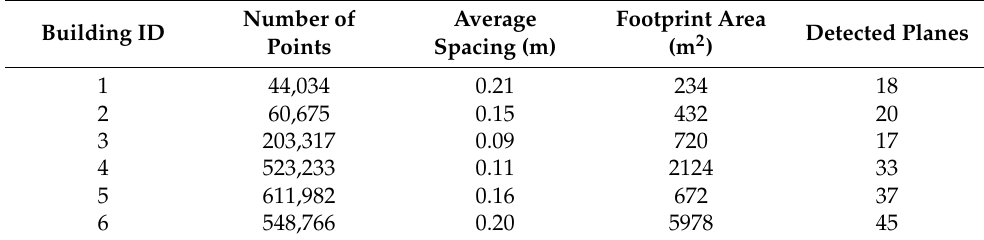
Table 1. Basic information related to the test